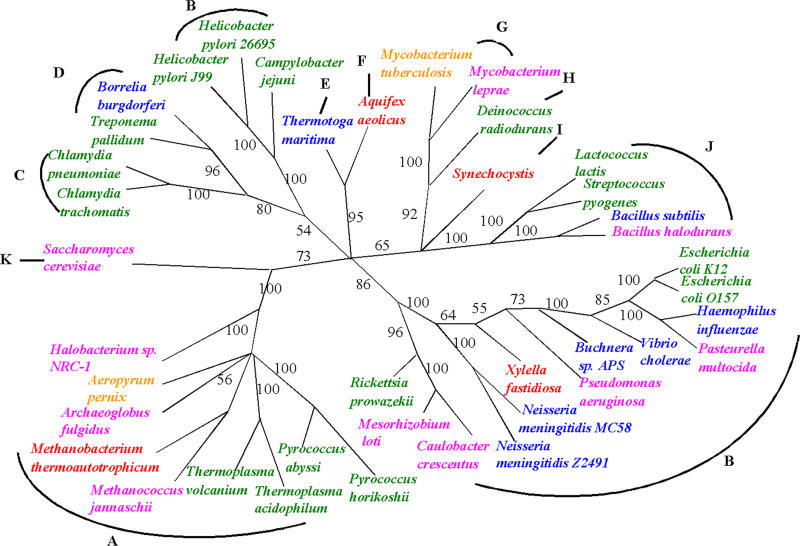
The W-G Tree Based on the Median Tree AlgorithmA subset of high-quality COG entries, which covers at least seven genomes, was used to build the W-G tree (see Materials and Methods). Branches with bootstrap scores less than 50% were collapsed into the polytomous form. Three domains of life are shown as (A) Archaea, (B–J) Bacteria, and (K) Eukaryote. Species are labeled with different colors based on their inferred HGT rates: red, >4%; yellow, 3%–4%; pink, 2%–3%; blue, 1%–2%; green, <1%. Taxonomy labels are (A) Euryarchaea, (B) Proteobacteria, (C) Chlamydiae, (D) Spirochaetes, (E) Thermotogae, (F) Aquificae, (G) Actinobacteria, (H) Deinococcus, (I) Cyanobacteria, (J) Firmicutes, and (K) Fungi.